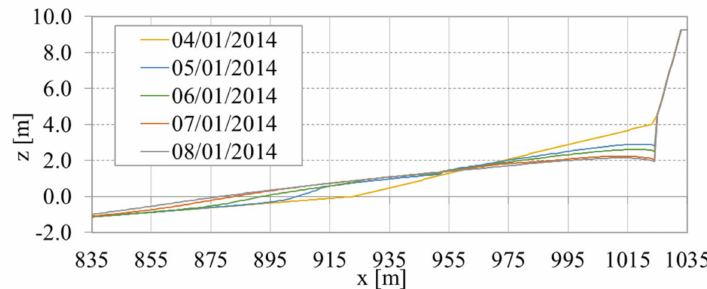
Figure 11. Storm induced morphological evolution of the sandy beach profile in case II.VP. Numerical profiles obtained using the XBeach Surfbeat numerical